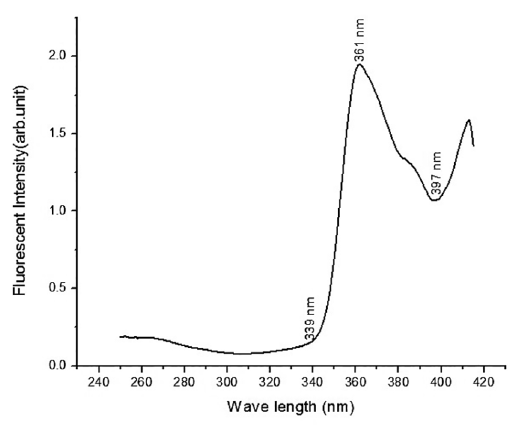
O (x=10 % and x 1 = 0.5 2 5 to ground j